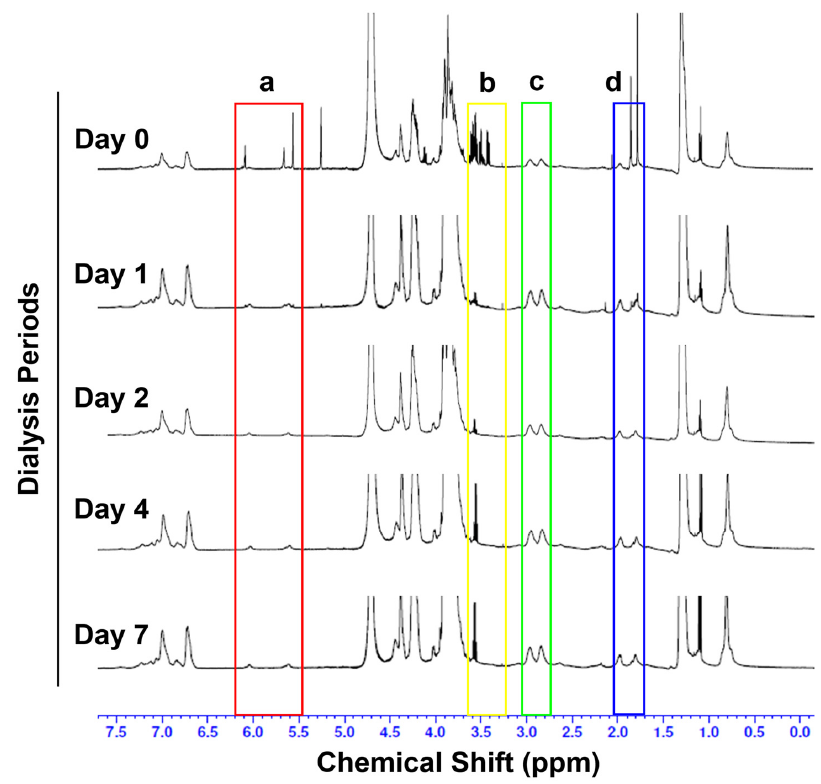
Figure 2. 1 H-NMR spectra of each dialysis sample from modified silk fibroin with glycidyl methacrylate. The modifications of lysine residues were demonstrated for the following: a. Methacrylate vinyl signal at δ = 6.2–5.6 ppm (red box); b. amine ( δ = 3.2–3.6 ppm, yellow box); c. lysine group signal at δ = 2.9 ppm (green box); and d. methyl group at δ = 1.8 ppm (blue box) in each dialysis sample from Silk-GMA.